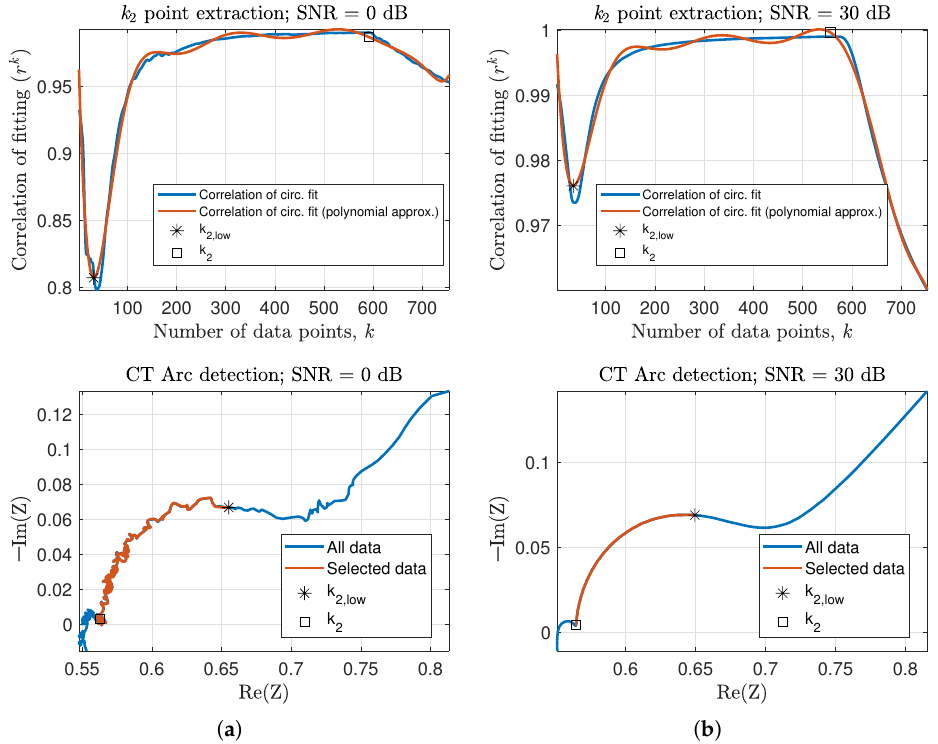
Figure 5. CT Arc detection. The top plots show the correlation fitting of the (84) along with threshold. The plots at the bottom show the detected CT arc in red. ( a ) Low SNR. ( b ) High SNR. It is obvious that at the first data points on the left side of the k 1 point in the Nyquist plot, the measured data does not fit a circular model. The point at which r k starts to increase is approximately where the CT Arc fits a circular model and is labelled as k 2, low . In addition, it must be expected that r k starts to drop for k > k 2 because the CT Arc semi-circle ends at k 2 . With this consideration, k 2 is estimated. The points between k k 2 are used for 2, low and CT-Arc parameter